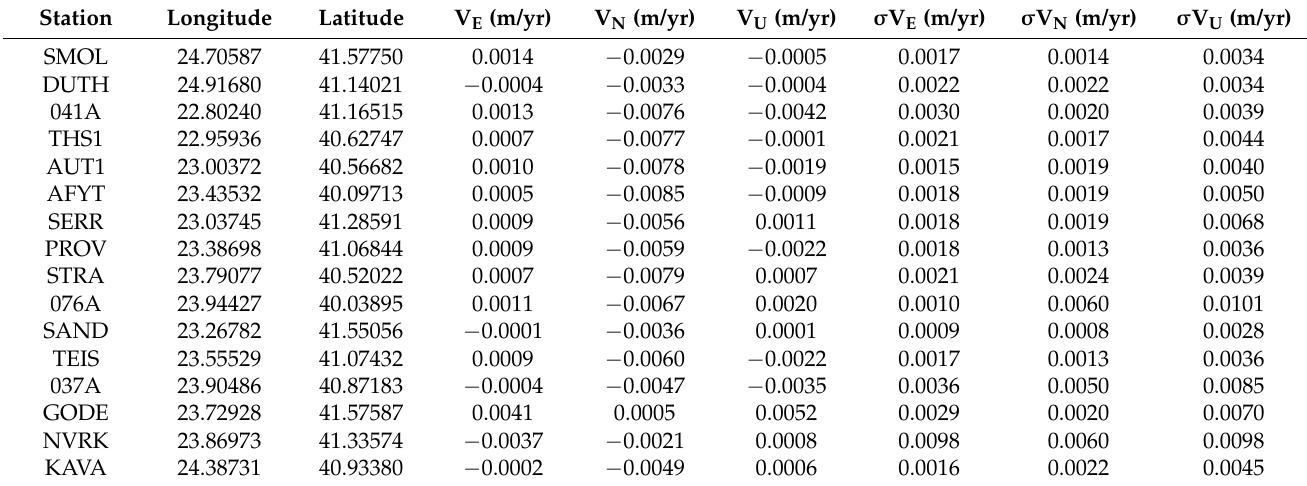
Table 1. East, north, and up velocity components of each GNSS